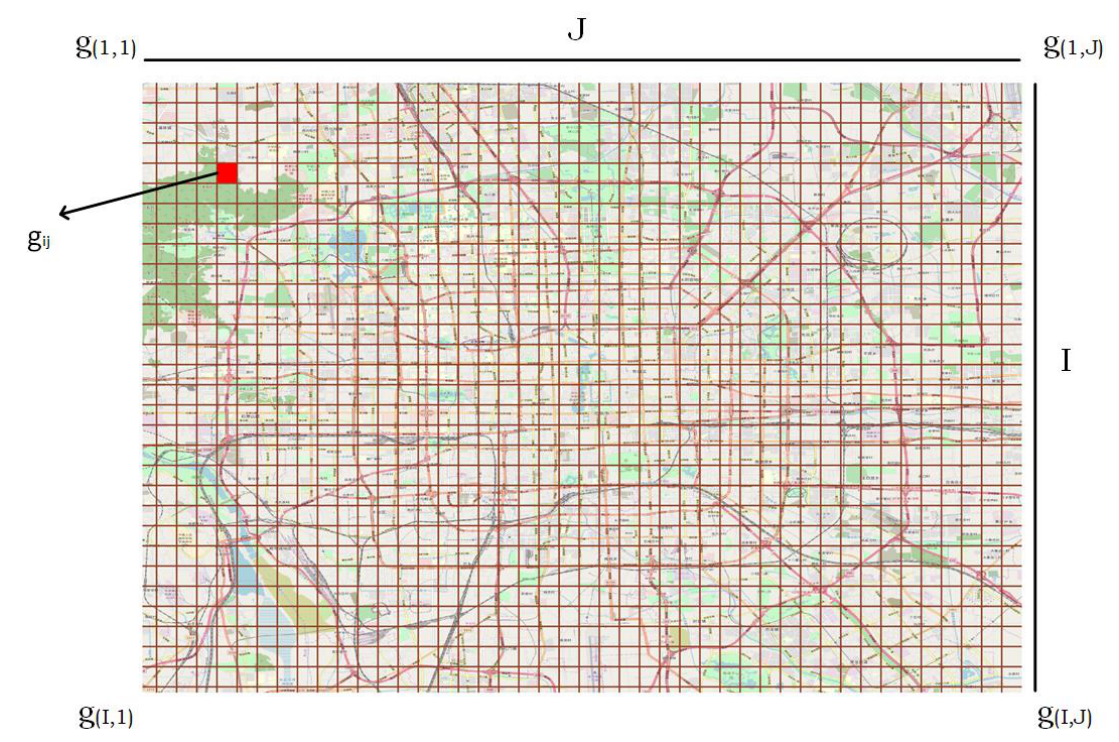
Figure 2. Map grid